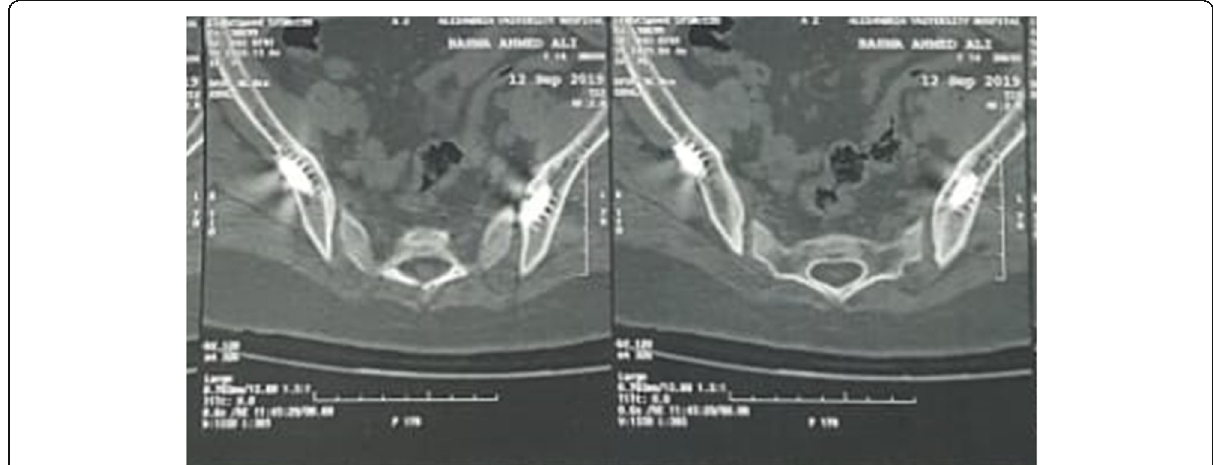
Fig. 4 Postoperative axial CT scan showing a posterior pelvic breach in a patient operated for lumbopelvic fixation due to congenital pars defect and L5-S1